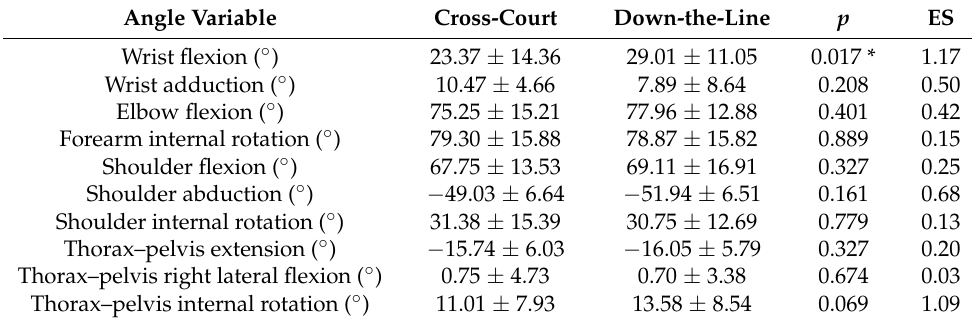
Table 2. Joint angle biomechanical variables of upper body at the impact ( n = 8). Angle